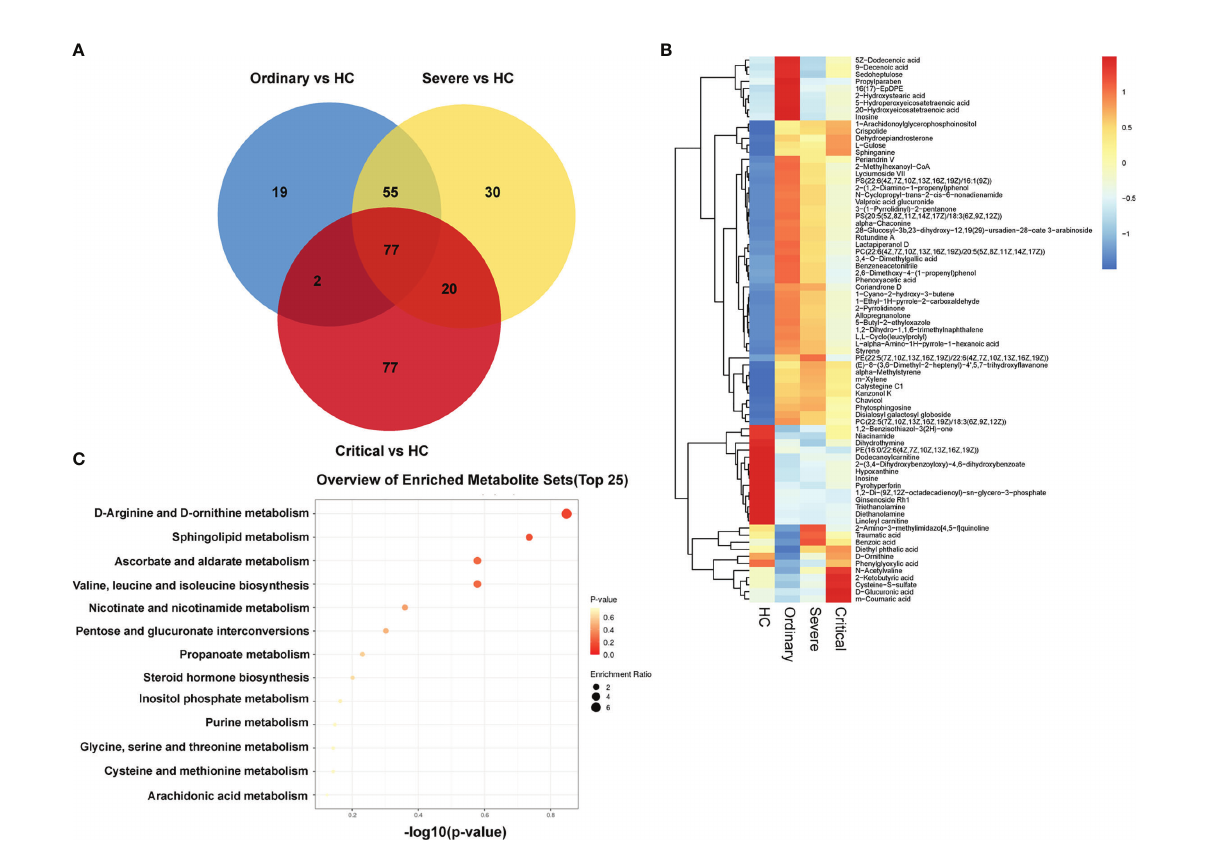
FIGURE 4 | Massive differences of metabolism in sera of COVID-19 patients. (A) Venn diagram of negative and positive ion differential metabolites in the ordinary group, severe group, and critical group compared with healthy control. The number of differential metabolites is shown in each section. (B) Heat plot of the hierarchical clustering of differential metabolites. (C) Scatter plot of 13 differential metabolites with the most signi fi cant enrichment. p -value is plotted in a color